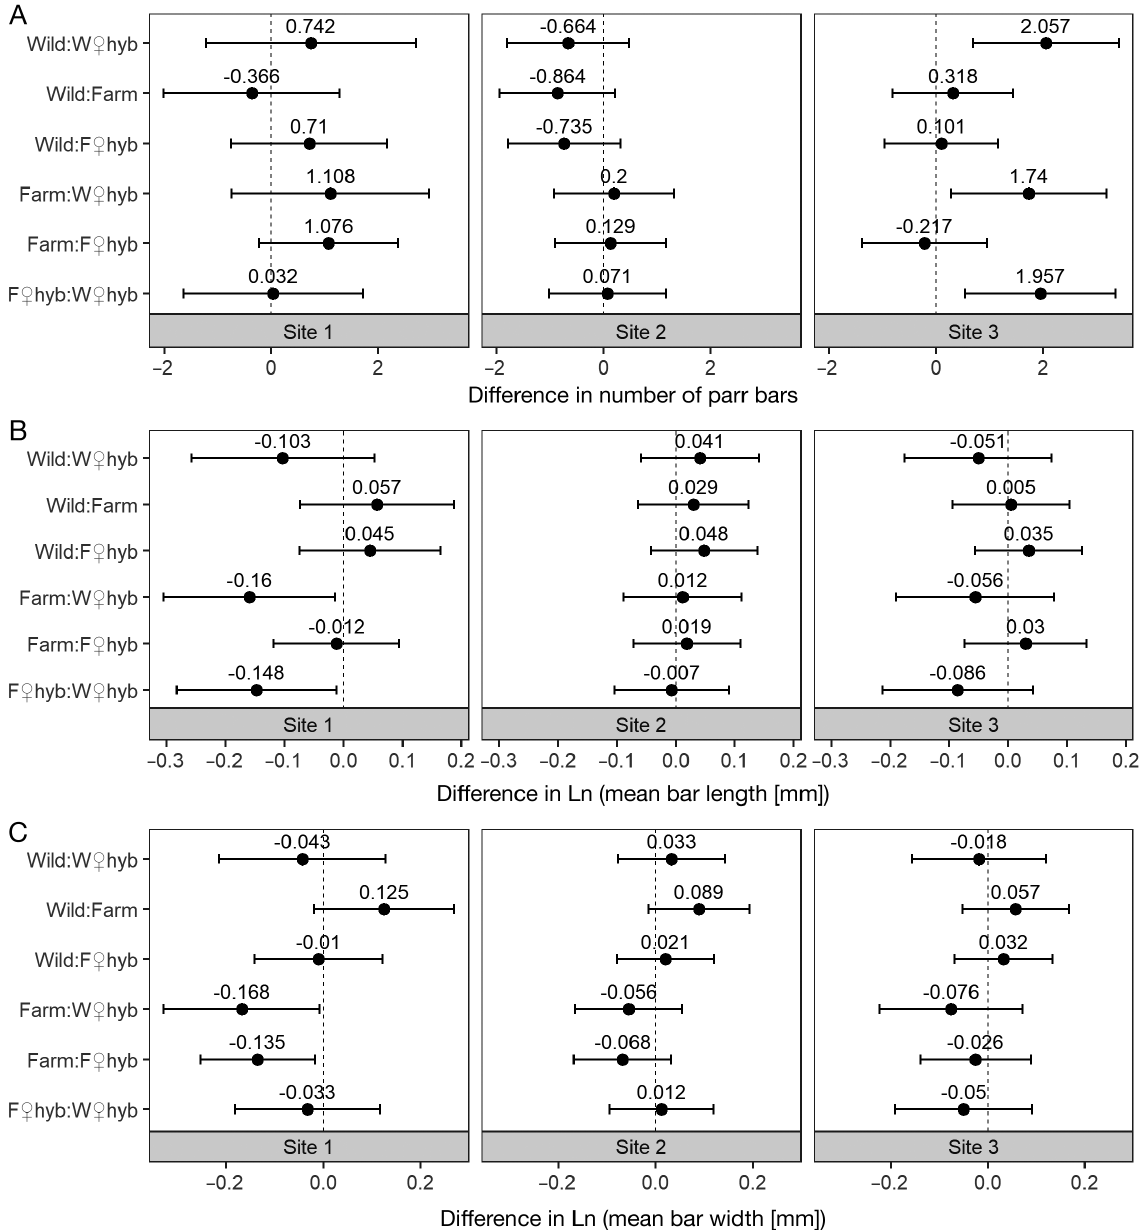
Fig. 8. Differences in (A) mean number of parr marks; (B) mean ln(parr mark length) below lateral line; and (C) mean ln(parr mark width) for each cross type pair of Atlantic salmon at each site. Error bar: ±2 SE of the difference estimate. Differences were calculated at the grand mean of standard length (45.20